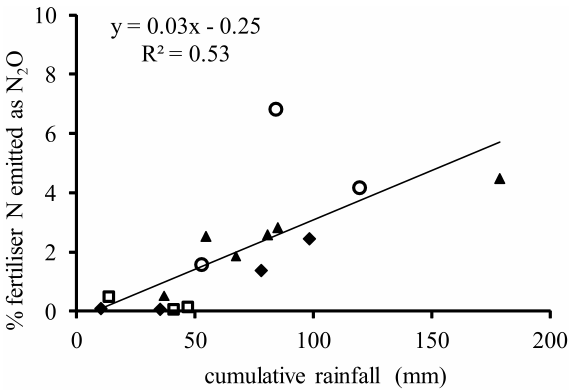
Fig. 4. The role of rainfall in determining N 2 O emission rates after N fertilisation. Data are average N 2 O fluxes measured in the three weeks after fertilisation (expressed as the percentage of fertiliser N applied) and the cumulative rainfall in the week before plus three weeks after fertiliser application. Different symbol types represent emission factors in 2007 (circle), 2008 (triangle), 2009 (diamond), and 2010 (square).